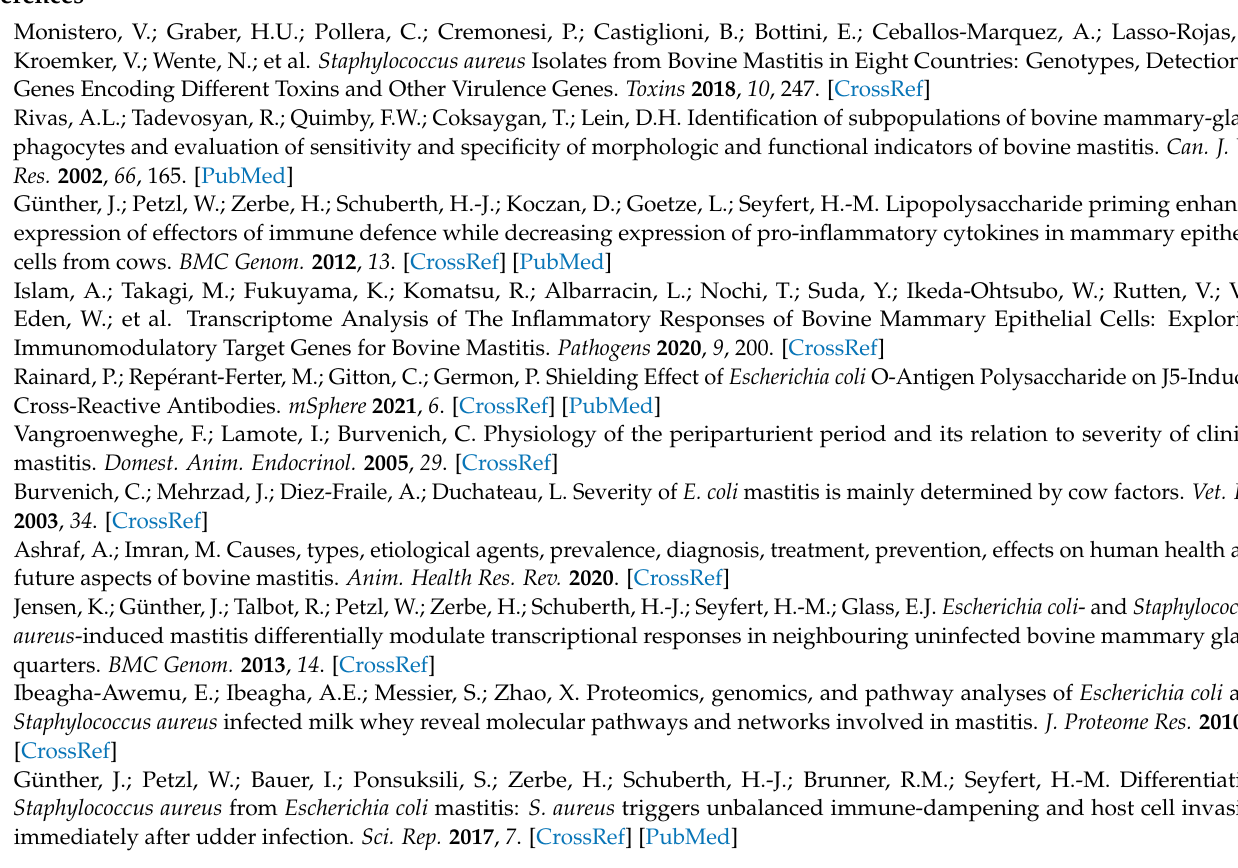
sites for: E. coli vs.